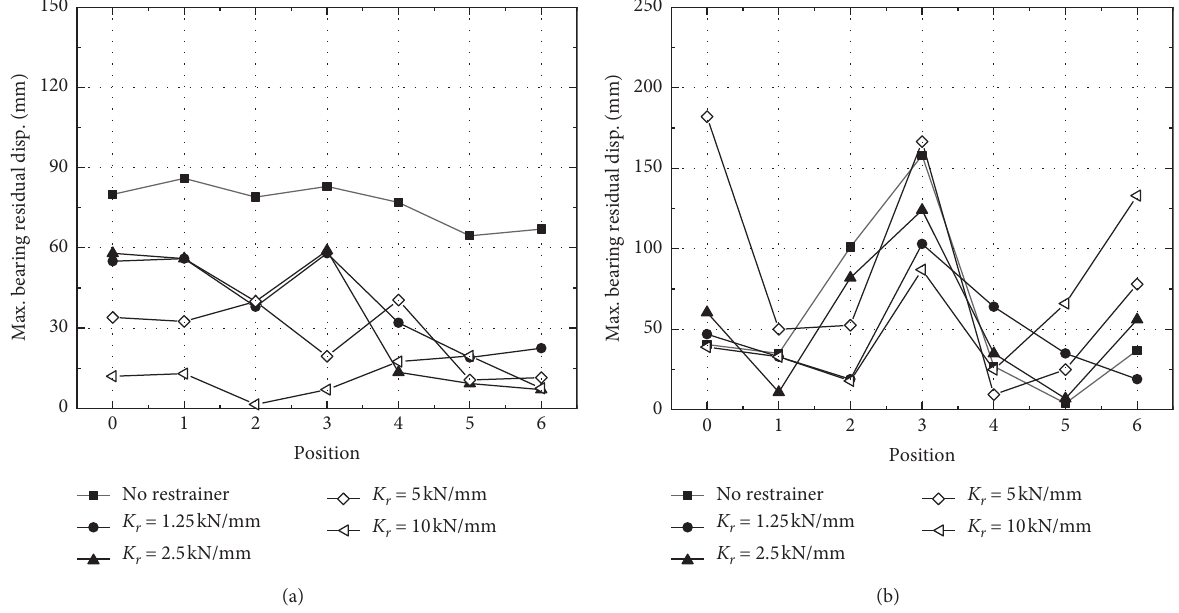
Figure 13: Comparison of maximum residual displacements of bearings. (a) Longitudinal direction. (b) Transverse direction. Table 5: Percentages of decrease in the maximum residual displacements of bearings. Stiffness of cable Position